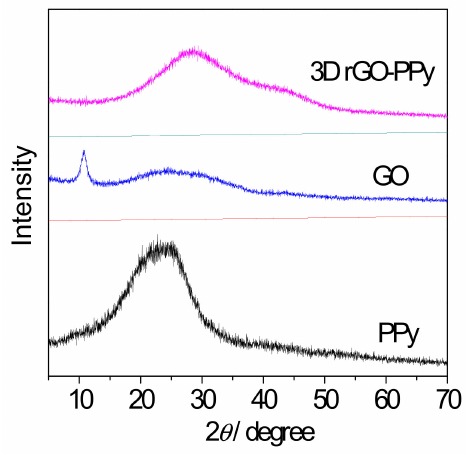
Figure 5. X-ray diffraction (XRD) patterns of PPy, graphene oxide (GO) and 3D